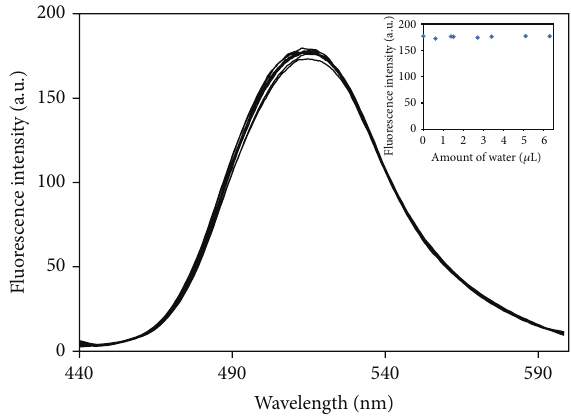
Figure 7: Fluorescence spectra ( 𝜆 acetonitrileasafunctionofwater.0 𝜇 L,0.6 𝜇 L,1.38 𝜇 L,1.5 𝜇 L,2.7 𝜇 L, 3.4 𝜇 L, 5.1 𝜇 L, and 6.3 𝜇